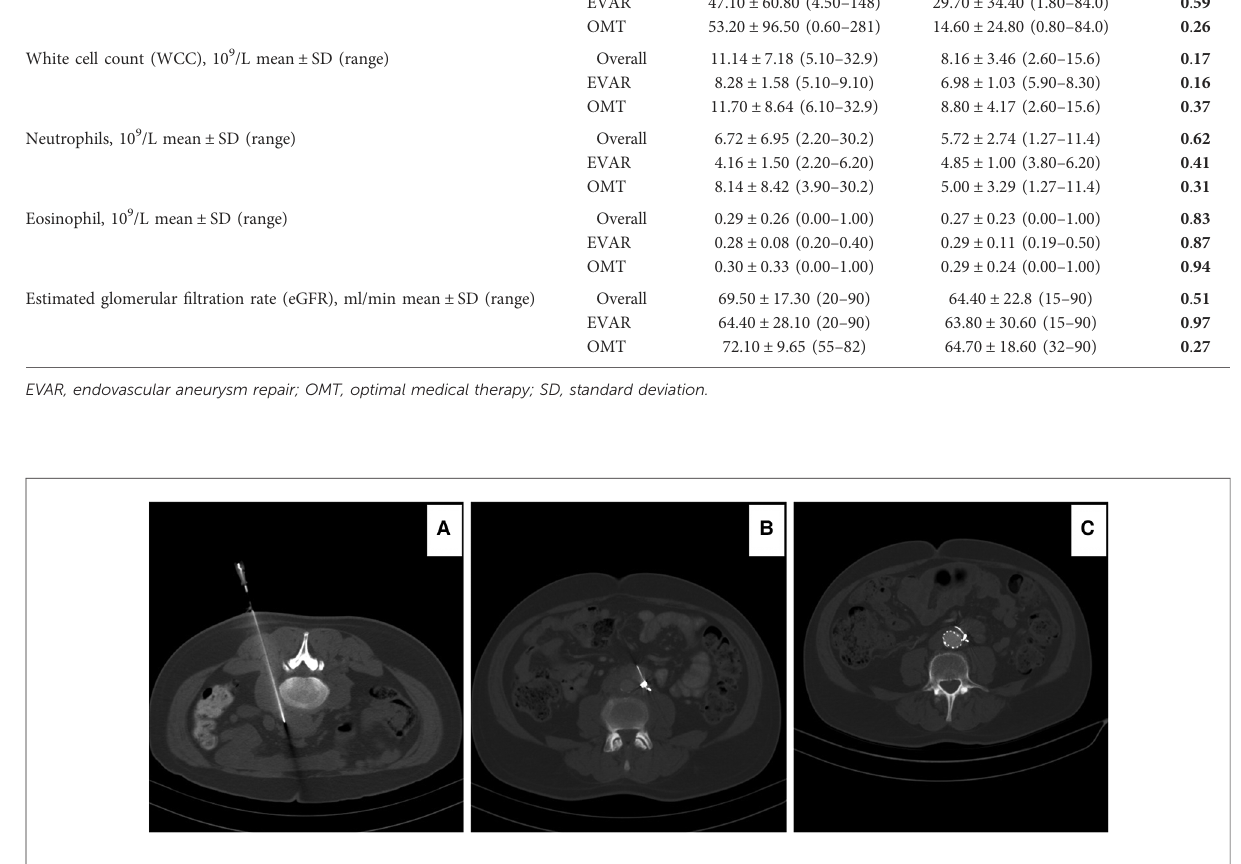
FIGURE 4 Computed tomography angiography (CTA) images illustrating: ( A ) percutaneous computed tomography (CT) scan guided biopsy of the retroperitoneal tissue in a prone patient. The patient developed bleeding during the biopsy. ( B ) the patient required three COOK coils (COOK medical LLC, Bloomington, IN) to stop the bleeding. ( C ) The patient was medically resistant and required EVAR 14 months post diagnosis. Note that the coils are now in the retroperitoneal space as the enhancements of the retroperitoneal fi brous tissue disappeared